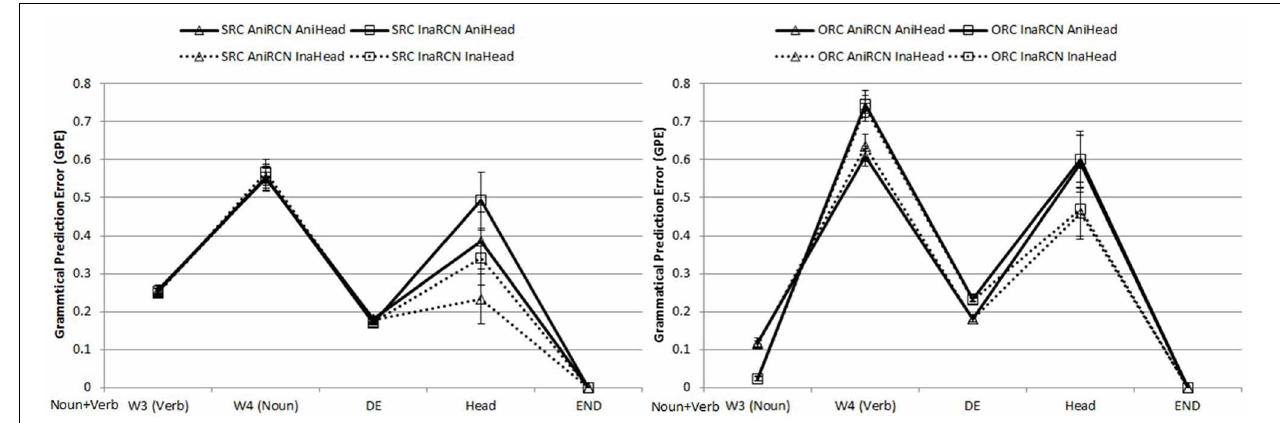
FIGURE 4 | Word-by-word GPEs of object-modifying SRCs (left panel) and ORCs (right panel) in the critical RC region, the head, and next word after the head. All sentences began with a Noun + Verb sequence, not shown in the graphs.